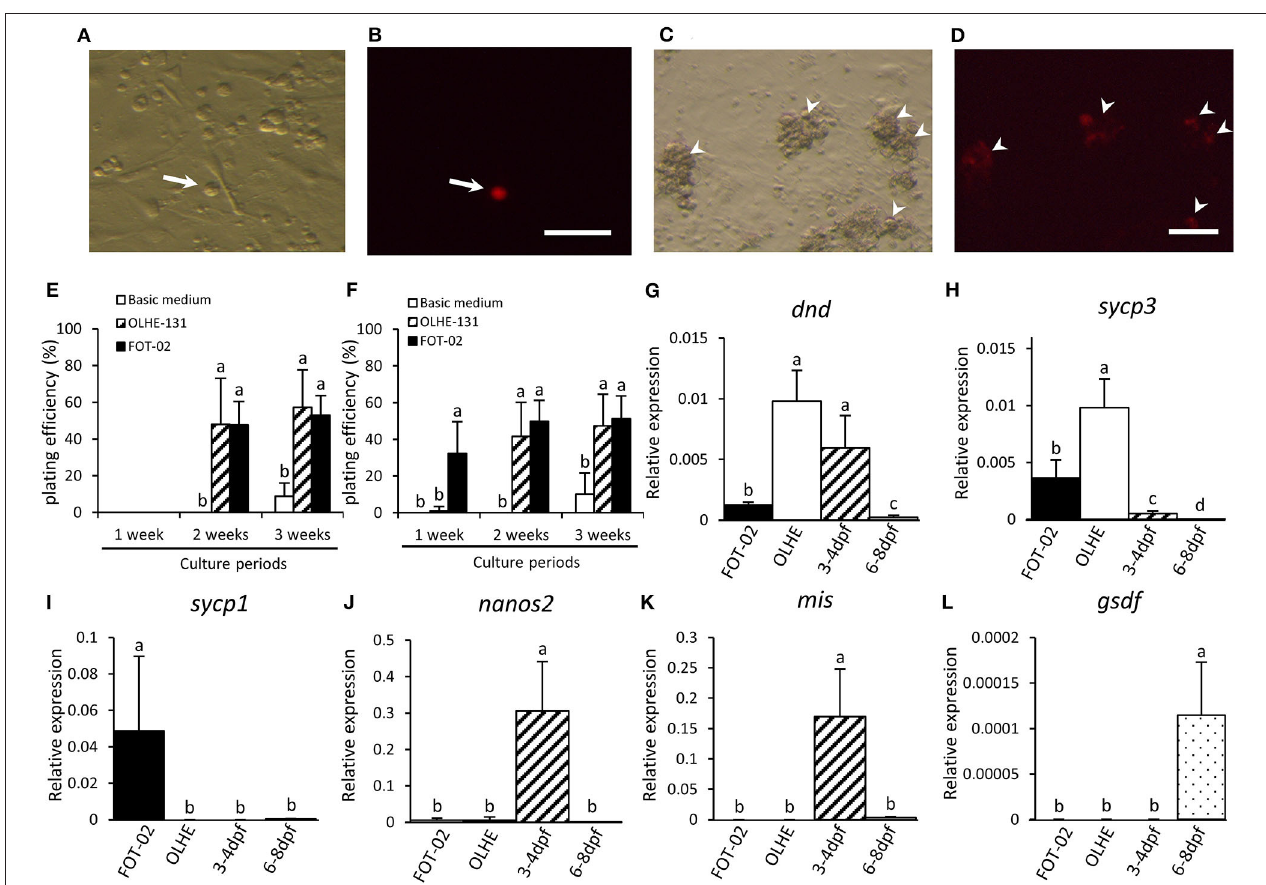
FIGURE 5 | Characteristics of PGCs co-cultured with FOT-02 or OLHE-131 cells. DsRed fluorescence in a PGC dissociated from 6 to 8 dpf embryo in bright field (A) and in dark field (B) . Non-DsRed expressing cells are feeder cells or other somatic cells. DsRed fluorescence in colonizing PGCs co-cultured with FOT-02 for 1 week in bright field (C) and in dark field (D) . White arrow: DsRed-positive PGC; White arrowhead: DsRed-positive colonizing PGCs. Scale bar: 100 µ m. PGC plating efficiency from 3 to 4 dpf (E) or 6–8 dpf embryos (F) . The assay conditions compared co-culture with FOT-02 or OLHE-131, and culture under basic medium. The PGCs cultured with FOT-02 had significantly colonized within 1 week. Confirmation of mRNA expression in colonizing cultured PGCs and gonadal regions from 3 to 4 dpf and 6–8 dpf embryos by qRT-PCR. dnd (G) and sycp3 (H) were expressed in the PGCs co-cultured with FOT-02 and OLHE-131; sycp1 (I) was confirmed only in PGCs co-cultured with FOT-02; nanos2 (J) was not expressed in colonizing cultured PGCs; mis (K) and gsdf (L) were expressed in the gonadal region only. FOT-02: PGCs co-cultured with FOT-02; OLHE: PGCs co-cultured with OLHE-131; 3–4 dpf: gonadal regions from 3 to 4 dpf embryos; 6–8 dpf: gonadal regions from 6 to 8 dpf embryos. Vertical bar: mean ± standard error of triplicates or more; a, b, c, d, and ab: significant difference ( p < 0.05) using Tukey’s multiple comparison test following one-way